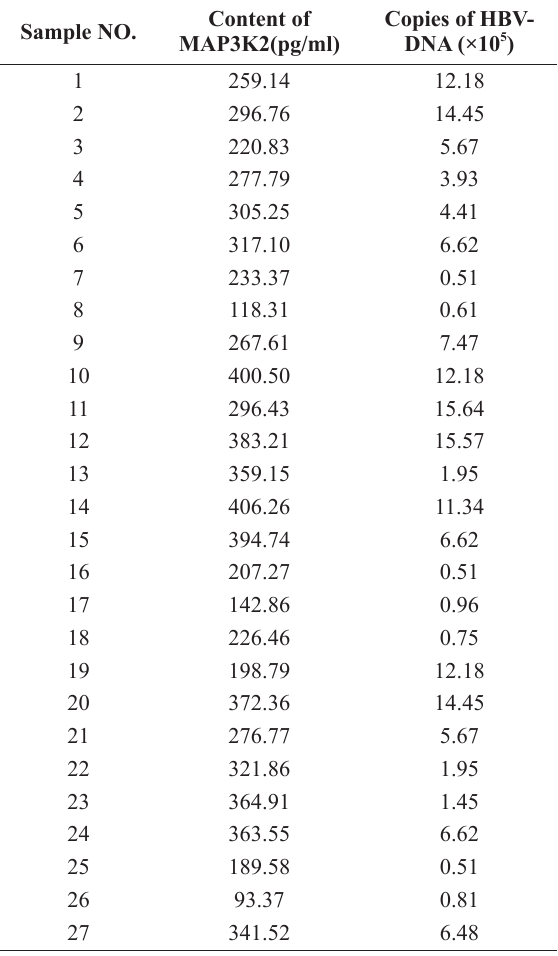
Copies of HBV-DNA and content of MAP3K2 in the serum from 27